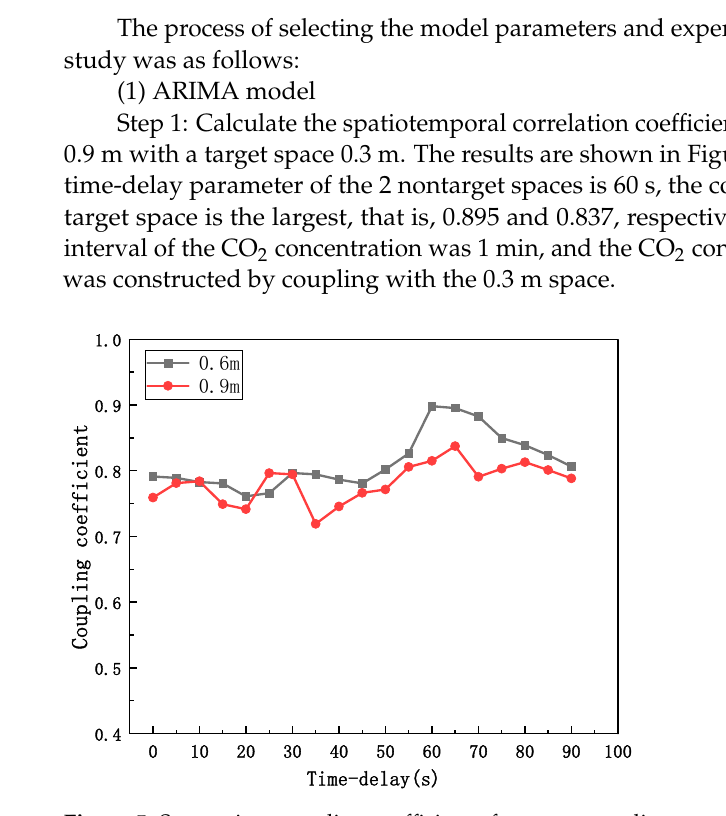
Figure 5. Space–time coupling coefficient of target space distance.